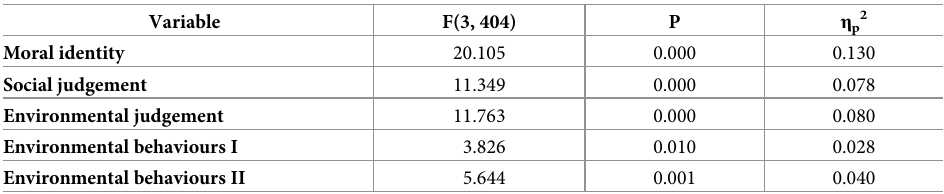
Table 9. ANOVA results.